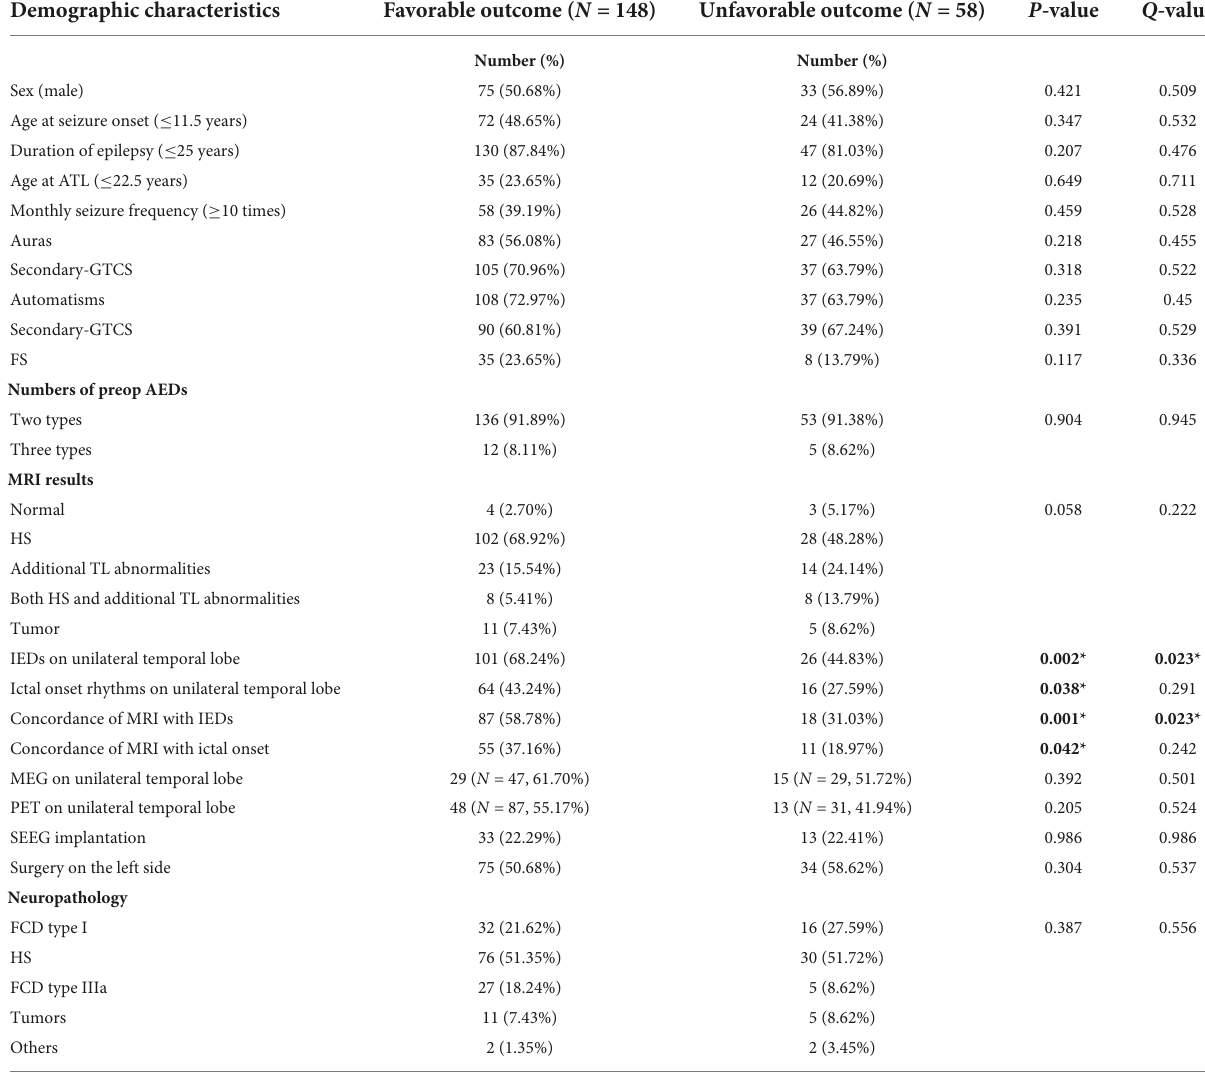
TABLE 3 Adults’ demographic characteristics and their relationship with seizure outcomes.